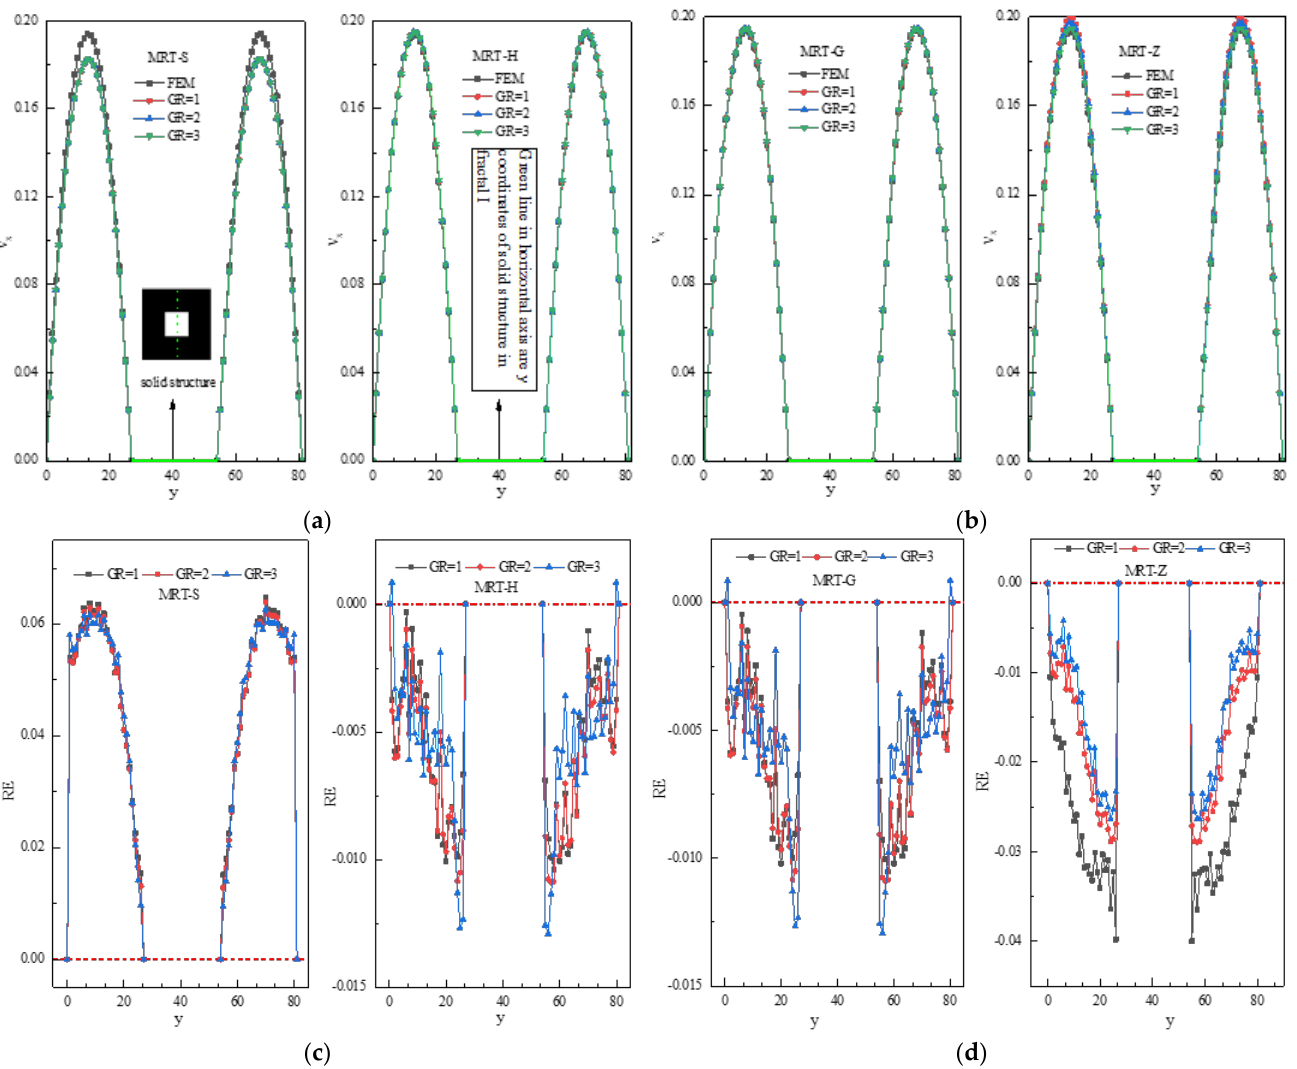
Figure 6. ( a , b ) The profiles of v x along vertical centerline of ROI (x = 140.5) in fractal I. ( c , d ) RE curves of v x along vertical centerline of ROI (x = 140.5) in fractal I.